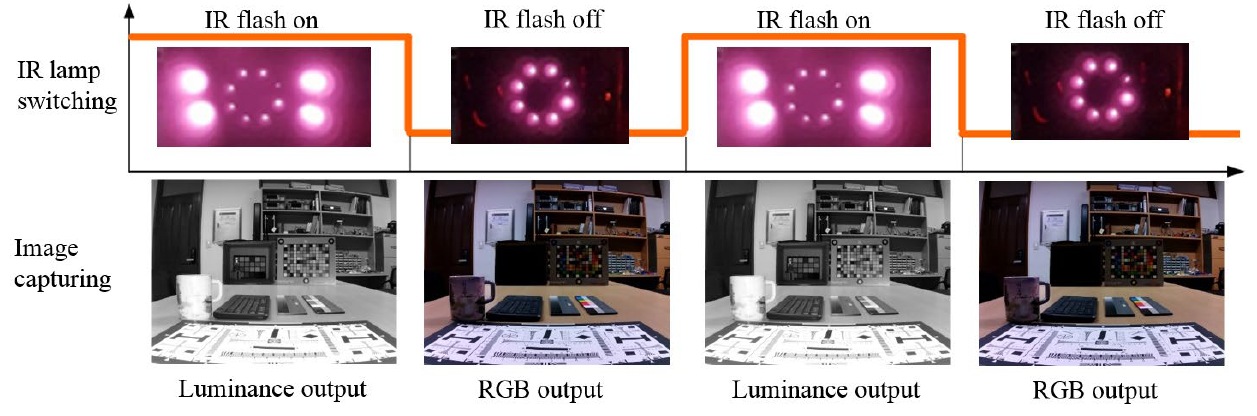
Figure 11. Sequence of image switching capturing with IR flash.